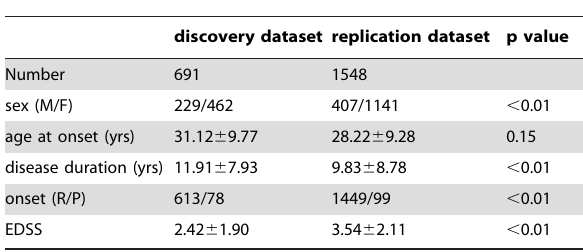
Table 1. Demographic and clinical characteristics of MS subjects.